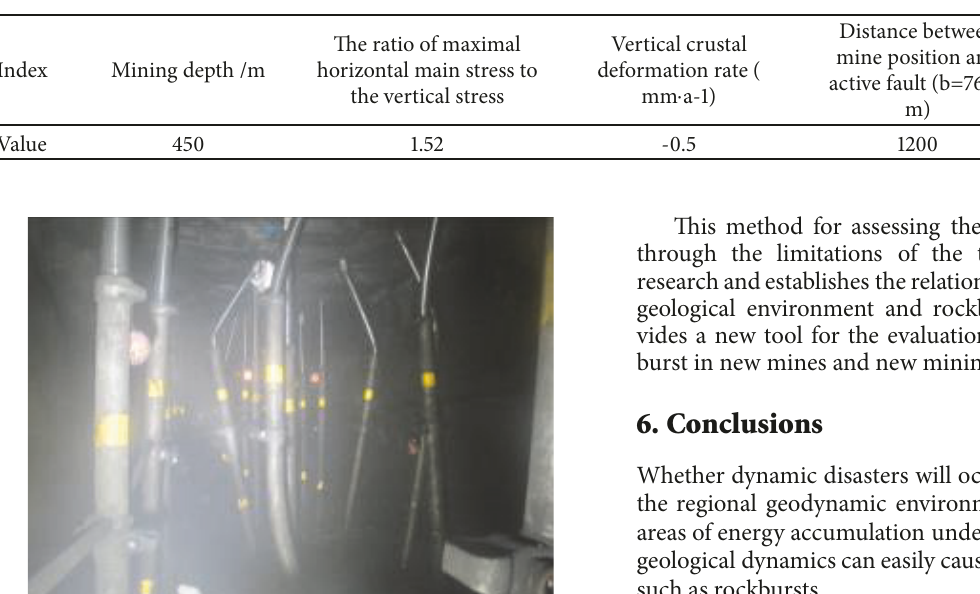
Table 11: The value of each rockburst impact factor in the Tongxin coal mine.